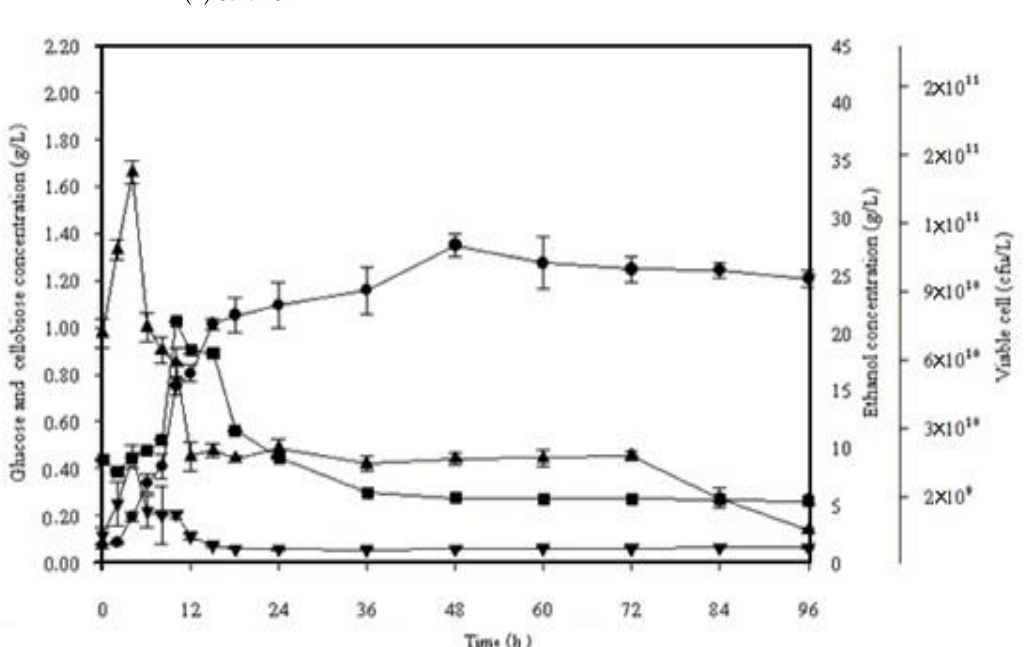
Figure 3. Simultaneous saccharification and fermentation of 10% ( w/v ) alkaline pretreated frond fibers incubated with S. cerevisiae SC 90 at 40 °C for 96 h. ( ■ ) Viable cells, ( ▼ ) cellobiose, ( ▲ ) glu- cose, ( ● ) ethanol.